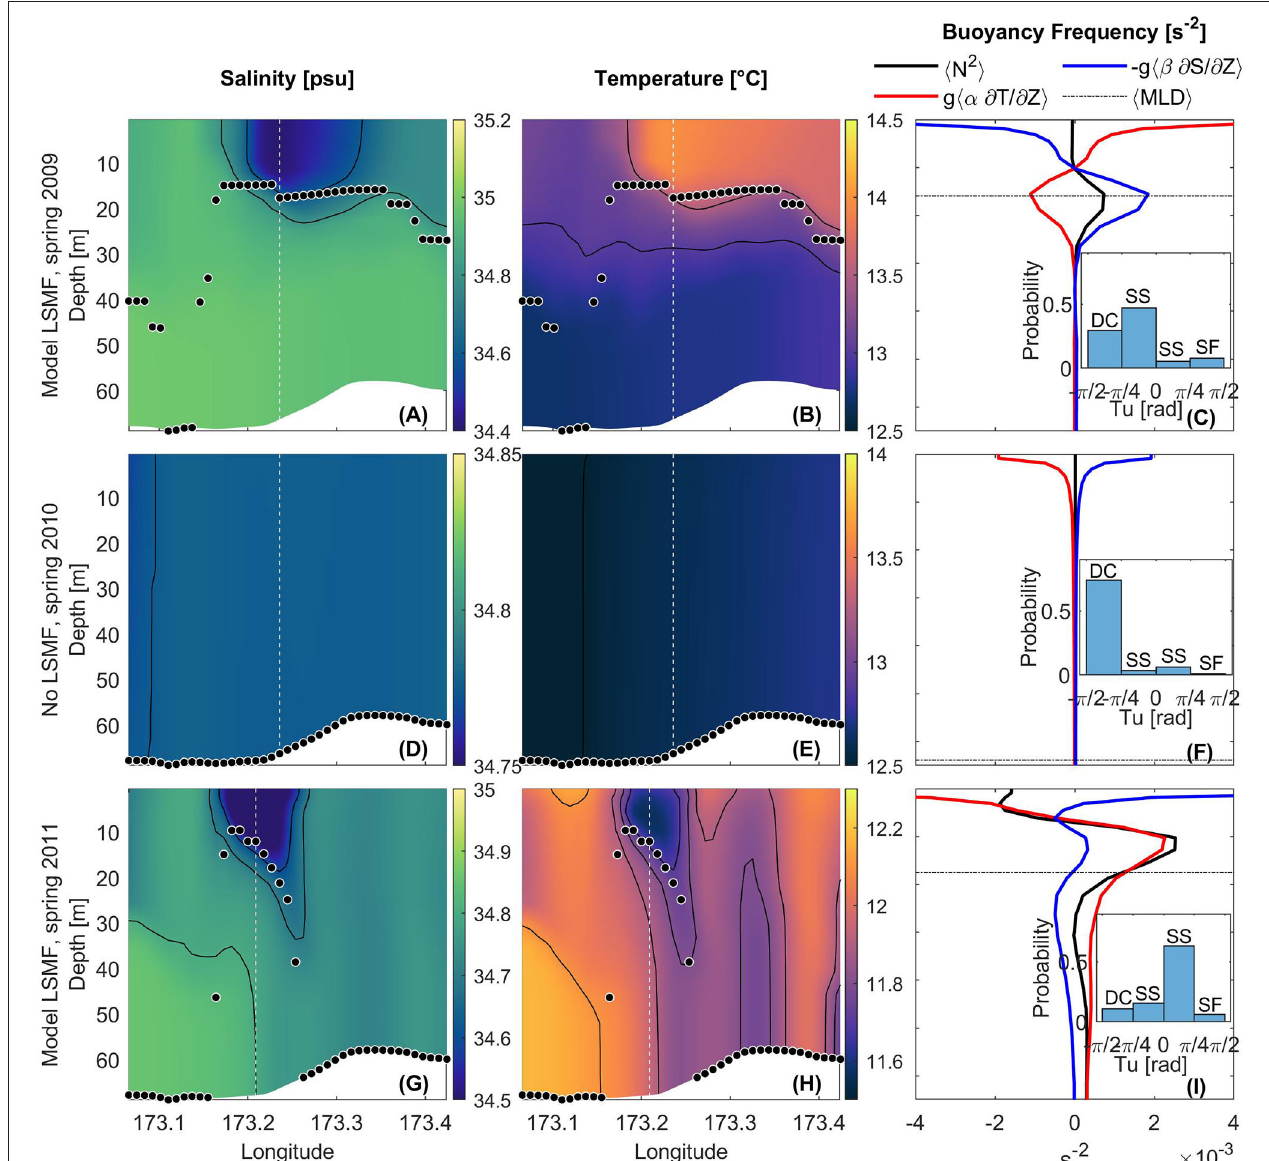
FIGURE 10 | Vertical structure of modeled (A,D,G) salinity, (B,E,H) temperature, and (C,F,I) buoyancy frequency N 2 (s − 2 , in black), with contributions from temperature (red) and salinity (blue) on November 4, 2009 (top panel), October 17, 2010 (middle panel), and August 28, 2011 (bottom panel) across transect indicated in Figure 8 . Black dots and black dashed line indicate (A,B,D,E,G,H) MLD across entire transect, (C,I) mean MLD across width of modeled LSMFs, and (F) mean MLD across the entire transect. Buoyancy frequency plotted for 1 profile (white dashed line). (C,I) Histograms of probability density function of Turner angle, Tu for all data points across width of modeled LSMFs in spring 2009 and spring 2011, and (F) across the entire transect during the absence of a modeled LSMF. DC, Diffusive convection; SS, Statically stable; and SF, Salt fingering.